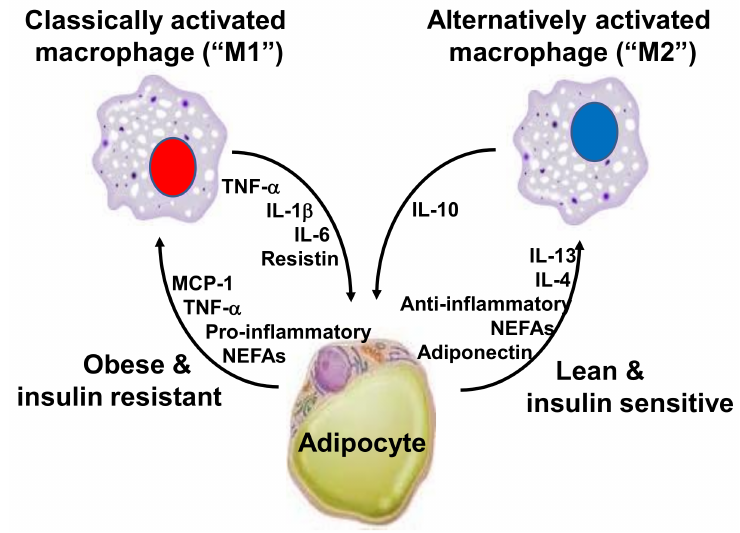
Figure 1. Interaction between M1 and M2 macrophages and adipocytes. Abbreviations: IL, interleukin; MCP, monocyte chemotactic protein; NEFAs, non-esterified fatty acids; TNF, tumor necrosis